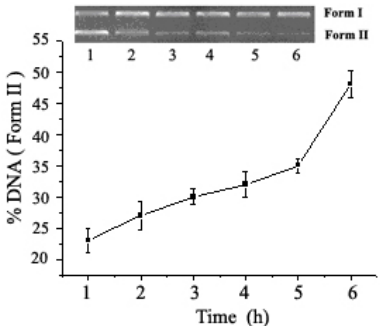
Figure 5. Time course of pUC19 DNA (0.008 µg/µL) cleavage promoted by 1b (6.25 × 10 − 7 mol/L) in pH = 7.4 buffers (5 mM Tris-HCl/10 mM NaCl) at 37 °C. Lanes 1–6, reaction time 6, 5, 4, 3, 2, 1 h, respectively. Molecules 2016 , 21 , 920